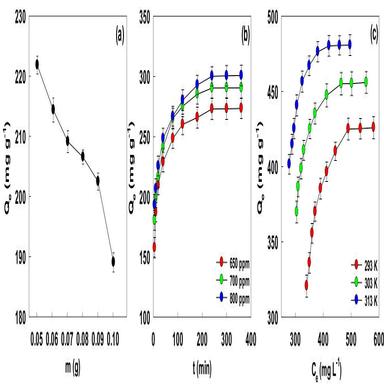
Influences of MnFe2O4@BAC dosage (a), initial OTC concentration/sorption time (b), and system temperature (c) on the OTC sorption by MnFe2O4@BAC.